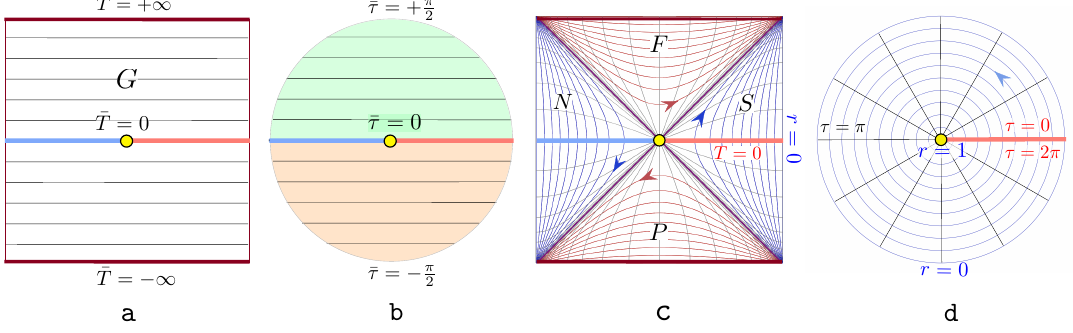
Figure 14 . Penrose diagrams of dS d +1 and S d +1 with coordinates D.10, D.12. Each point corresponds to an S d − 1 , contracted to zero size at thin-line boundaries. a: global dS in slices of d +1 constant ¯ T . b: Wick rotation of global dS to S d +1 . c: S/N = southern/northern static patch, d +1 F/P = future/past wedge; slices of constant T (gray) and r (blue/red) = flows generated by H . Yellow dot = horizon r = 1 . d: Wick-rotation of static patch S to S d +1 ; slices of constant τ and constant r